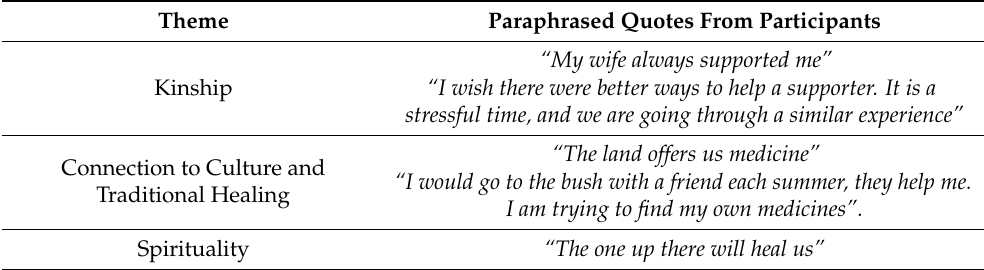
Table 2. Strengths and informal supports identified in sharing circle.